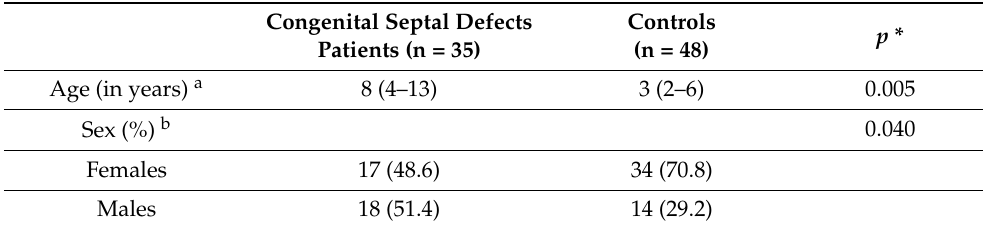
Table 1. Demographic characteristics of the study population.